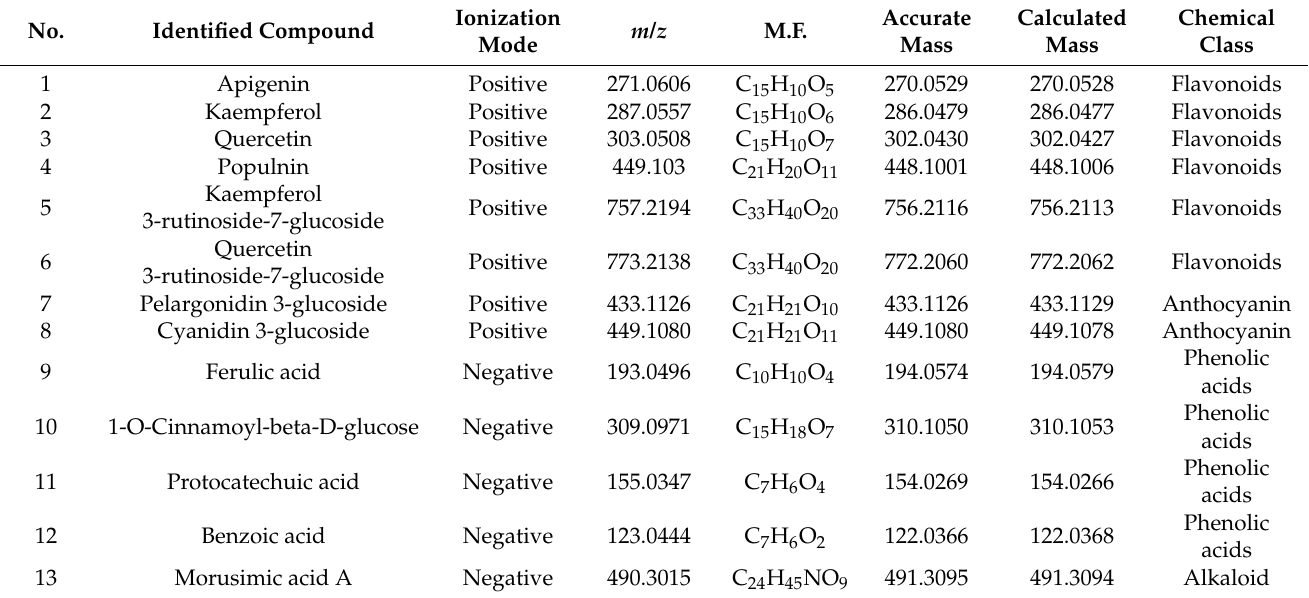
Table 1. LC-HRMS-Identified compounds in BBE . M.F., molecular